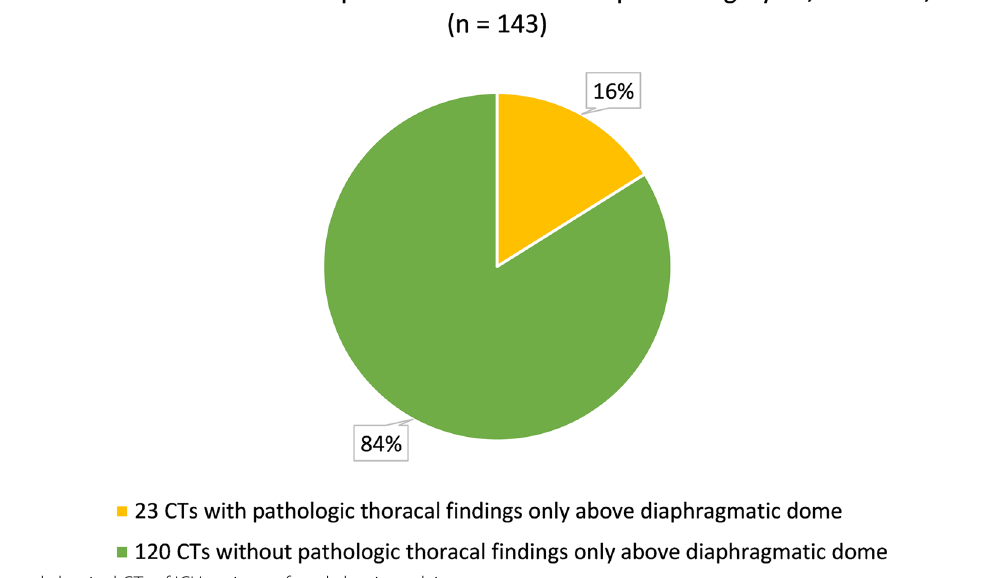
Fig. 3 Thoracoabdominal CTs of ICU patients after abdominopelvic